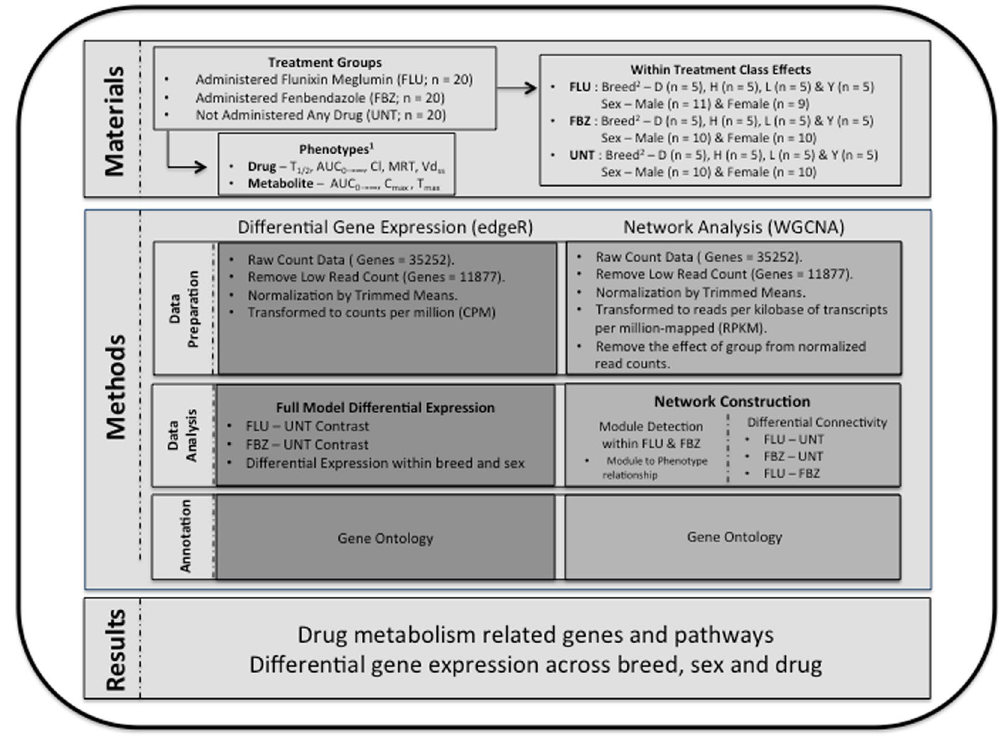
Figure 1. Number of animals within each treatment and workflow of RNA-Seq data analysis. 1 The pharmacokinetic (PK) phenotypes were half-life (T 1/2 ; h), area under the plasma concentration-time curve from time zero to infinity (AUC 0 →∞ ; h * μ g/mL), clearance (Cl; L/h/kg), mean residence time (MRT; h), volume of distribution at steady state (Vd ss; L/kg), peak concentration (C max ; μ g/mL) and time at which maximum concentration occurs (T max ; h). 2 Refers to breed and D = Duroc; H = Hampshire; L = Landrace; Y =